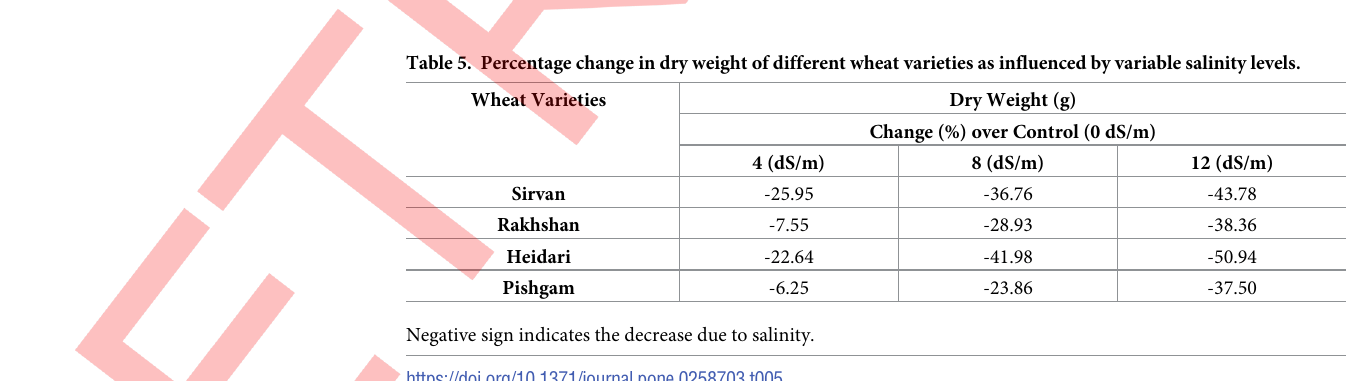
Table 5. Percentage change in dry weight of different wheat varieties as influenced by variable salinity